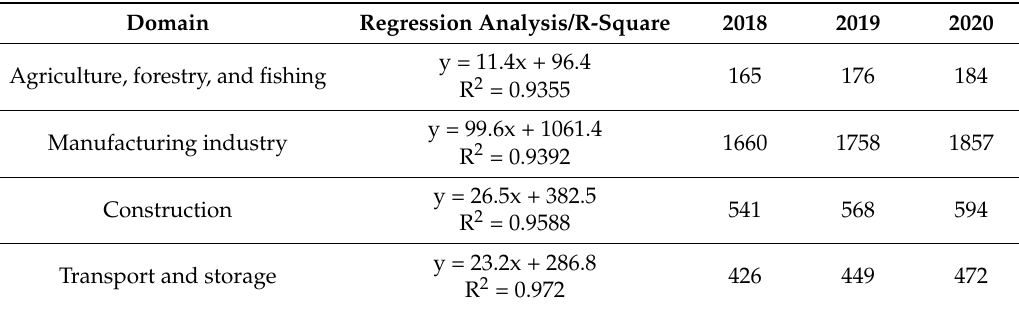
Table 8. Trends of accident at work for period 2018–2020 in Romania.